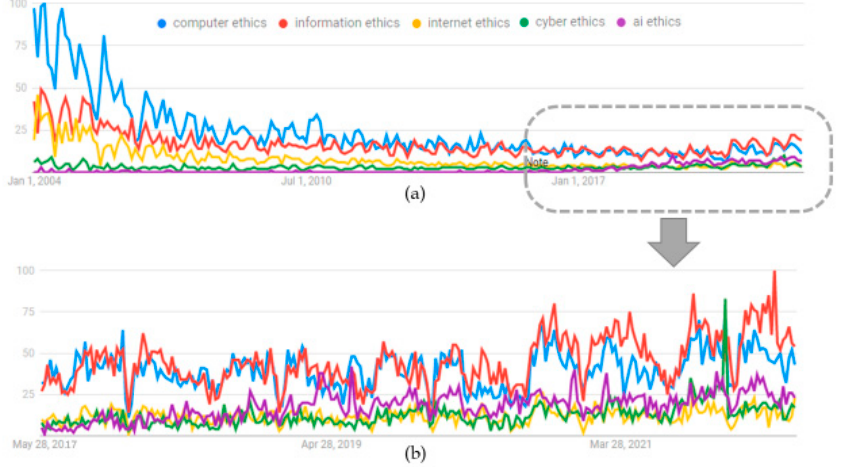
Figure 1. ( a ) Top: Google Trends search percentage for “computer ethics”, “information ethics”, “internet ethics”, “cyber ethics”, and “AI ethics” since 2004. ( b ) Bottom: Trends between 2017 and 2022.